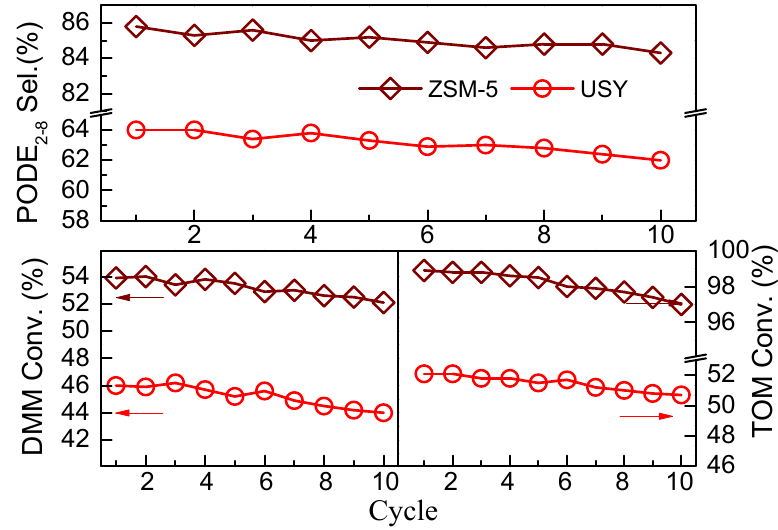
Figure 6. Reusability of the HZSM-5 (Si/Al = 17) and USY (Si/Al = 10) catalyst. The reaction was carried out at 90 °C for 45 min, with a feed DMM/TOM molar ratio of 2 and catalyst amount of 5 wt.%. After each test, the catalyst was reused in the next run following a simple centrifugation separation.